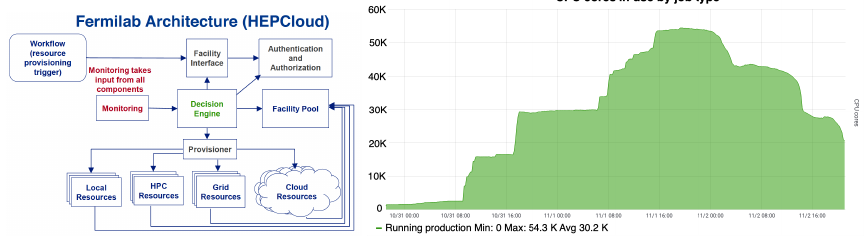
Figure 3. HPC resources integrated in the HEPCloud infrastructure schema (left) and NERSC CPUs recently in use running CMS simulation jobs